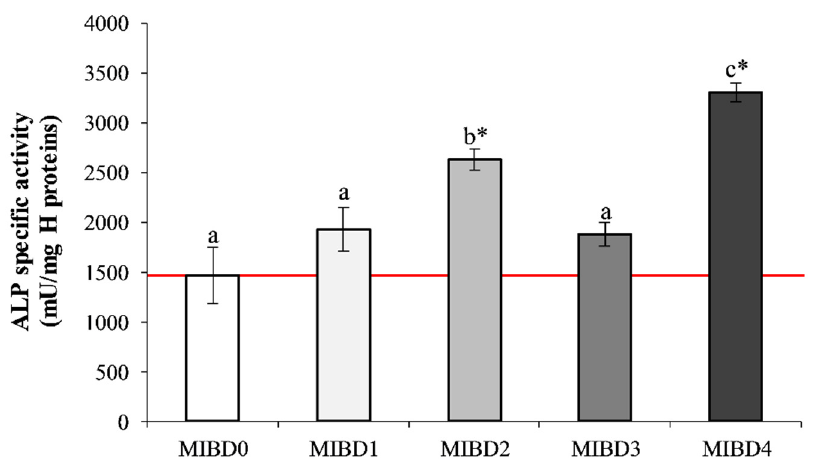
Figure 5. ALP activity of human Saos-2 osteoblast-like cells after incubation with in vitro MIBDs. ALP activity was measured after seven days’ incubation with 150 µ g / cm 2 MIBDs. Each bar represents the mean from two independent experiments. Asterisks indicate statistical di ff erences ( p < 0.05) from CTR cells, indicated in the graph as a red line, while di ff erent letters highlight significant di ff erences among MIBDs.